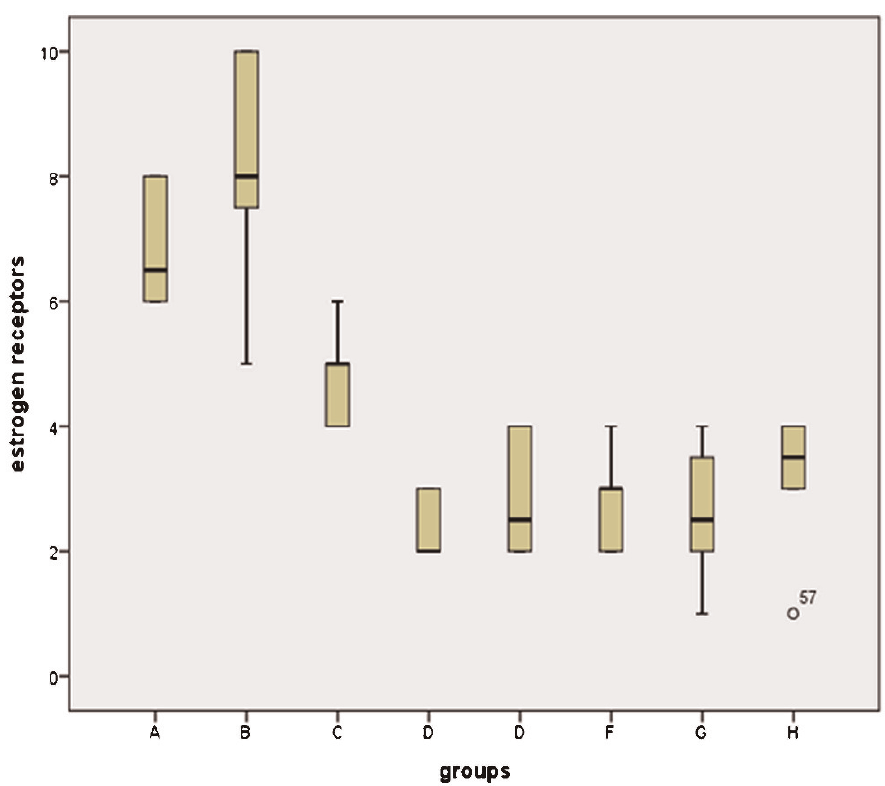
Figure 2 - The numbers of estrogen receptor-positive cells are presented in a box